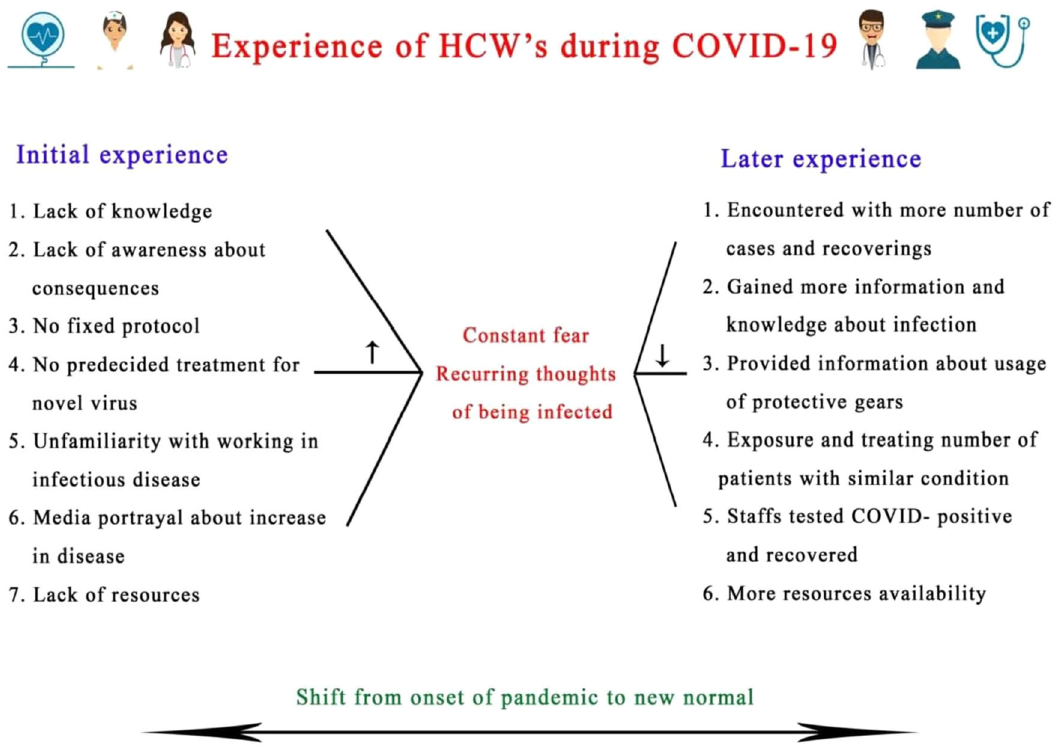
Fig. 2 Experience of HCWs. Shift from onset of pandemic to new